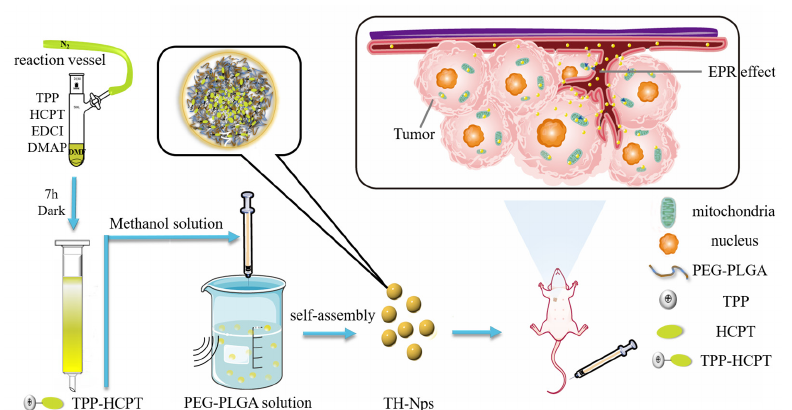
Figure 1. The schematic diagram showing the synthesis of TH, the preparation of TH-NPs by the anti-solvent precipitation method, how TH-NPs were in vivo delivered into tumor cells.